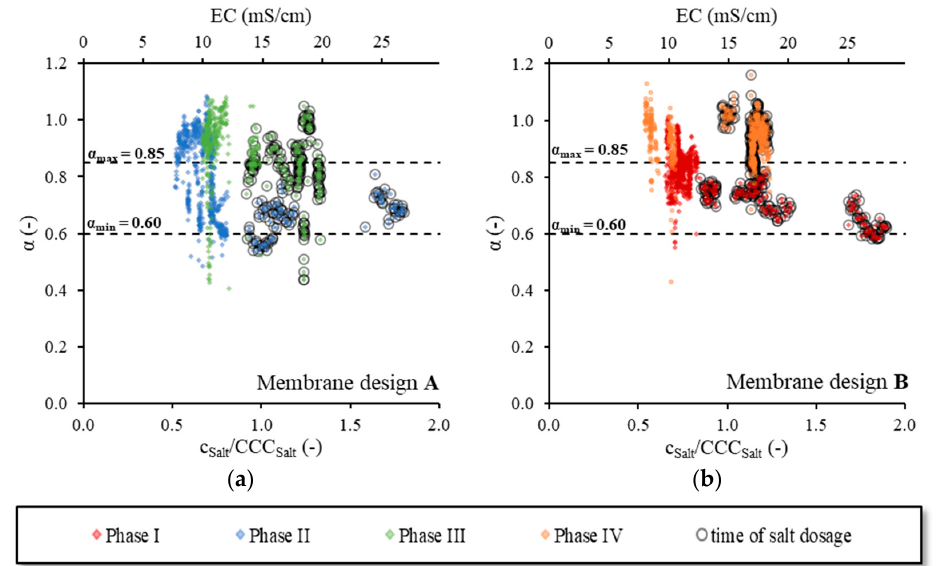
Figure 9. ( a ) α as a function of EC for diffuser membrane design A and ( b ) diffuser membrane design B.